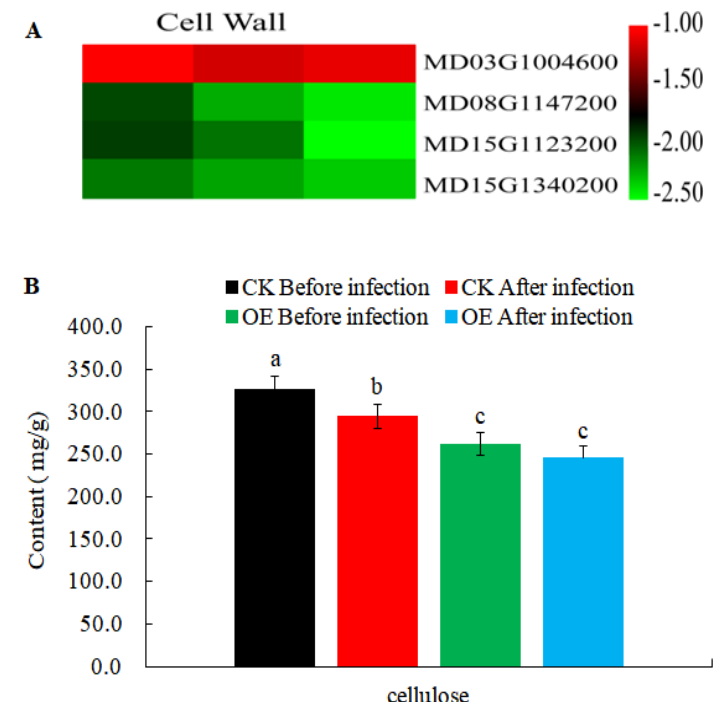
Figure 8. Expression levels of DEGs involved in cell wall reinforcement. ( A ). Heatmaps of DEGs involved in cell wall reinforcement. The log2|Foldchange| was colored using TBtools (red indicates the DEG was up-regulated in the MdMLP423 -overexpressing calli compared with Table S1. CK_1, T_2/CK_2, and T_3/CK_3) from left to right. ( B ). The content of cellulose before and after pathogen inoculation. The different lowercase letters indicate significant difference at p < 0.05.